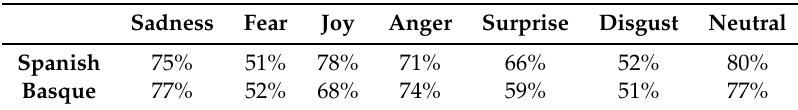
Table 1. Human recognition accuracy percentages for utterances as a function of language and emotions (taken from